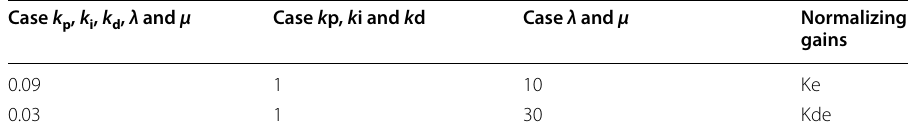
Table 1 Optimal values for normalizing gains of the three tuning cases Case k p , k i , k d , λ and μ Case k p, k i and k d Case λ and